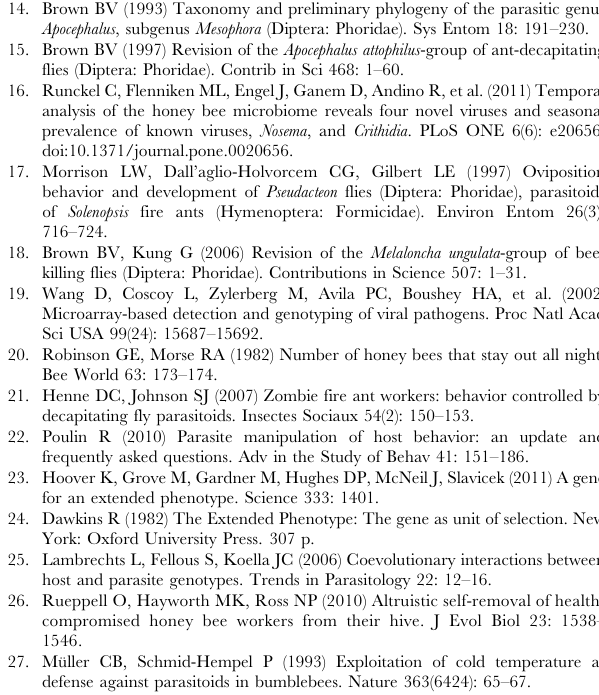
Figure S3 Timing of life history events in parasitism of honey bees by A. borealis . (A) Length of time after sample collection until phorid larvae emerged from their honey bee hosts (Mean = 7.14 days, SD= 1.68, n= 636). (B) Number of phorid larvae per infected bee for samples from various locations (Mean = 4.8, SD= 2.45, n= 961). (C) Length of pupal period (Mean = 27.9 days, SD= 1.9, n = 94). Figure S4 San Francisco State University Hensill Hall study site. (A) Primary study hive, blue arrow indicates direction that honey bees fly to reach the nearby light. (B) Landing above the hive where stranded bees were collected and the light (C) immediately above the landing showing honey bees attracted to it from the previous night. (D) A typical enclosure setup. Figure S5 The number of parasitized bees (red) com- pared to all bees (black) collected at the San Francisco State University Hensill Hall collection site. Notably, numerous bees were collected from the lights and landing in months even when parasitism rate was low. Our direct rearing method may have underestimated the rate of parasitism during spring 2010 since the Arthropod Pathogen Array (APM) indicated a higher rate of parasitism during April and early May than we observed in our rearings. The APM also detected a high level of infection with Nosema ceranae and deformed wing virus during that period. Table S1 Honey bee and bumble bee collection sites in the San Francisco Bay Area. Locations of hives which did not yield parasitism in the San Francisco Bay Area are shaded light grey. Locations where stranded and foraging honey bees and bumble bees were collected are shaded dark grey.